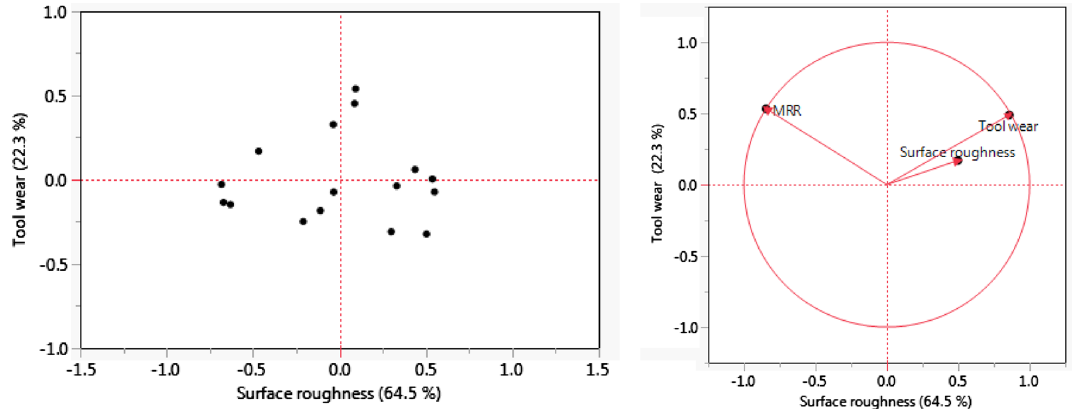
Fig. 7 Accountability proportion (AP) values of surface roughness vs. tool